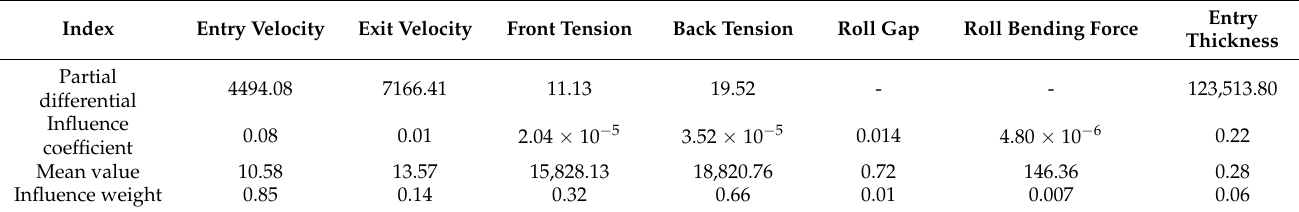
Table 4. Simulation calculation of influence